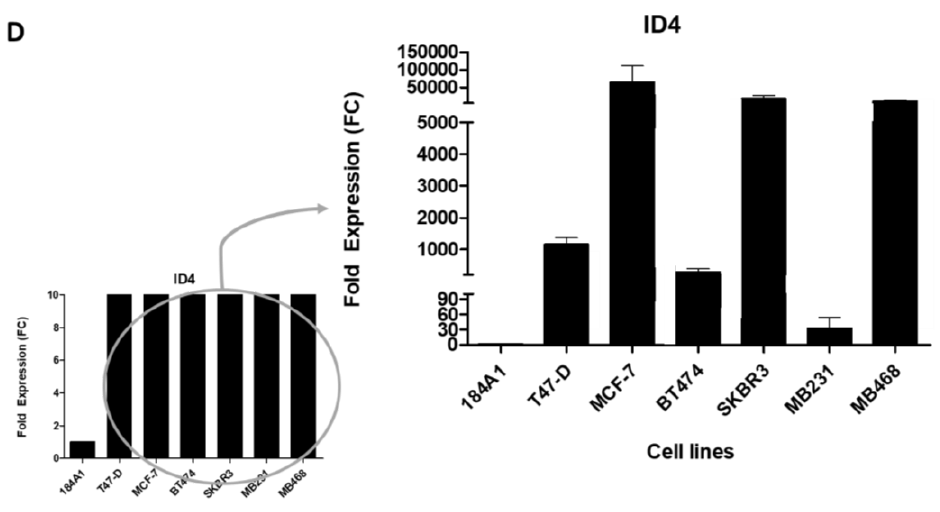
Figure 1. mRNA expression of ID genes ( A : ID1 , B : ID2 ; C : ID3 ; D : ID4 ) in six breast tumor cell lines (MCF-7, T47-D, BT-474, SK-BR-3, MDA-MB-231, and MDA-MB-468) and the breast epithelium cell line 184A1. All experiments were done three times. Each graph shows the average and standard derivation (error bars) of the three measurements. * p < 0.05 compared to all the other cell lines.